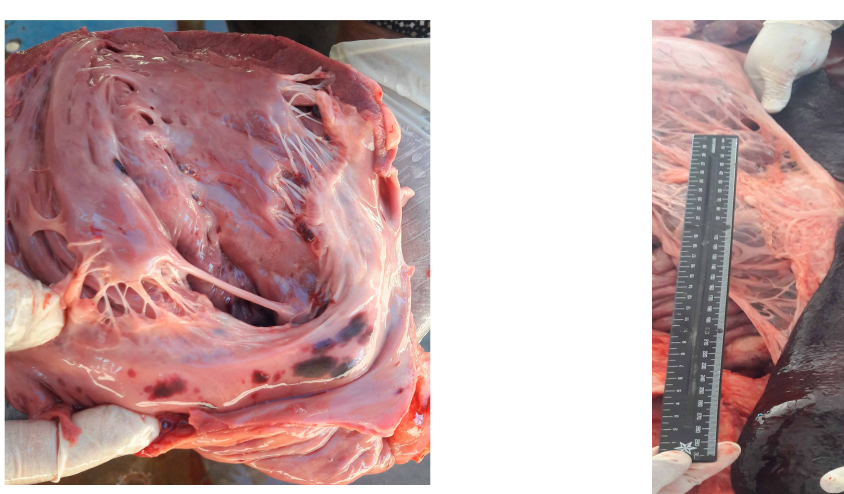
Figure 6: Cut surface of the heart showing ecchymotic endocardial atrial hemorrhages.